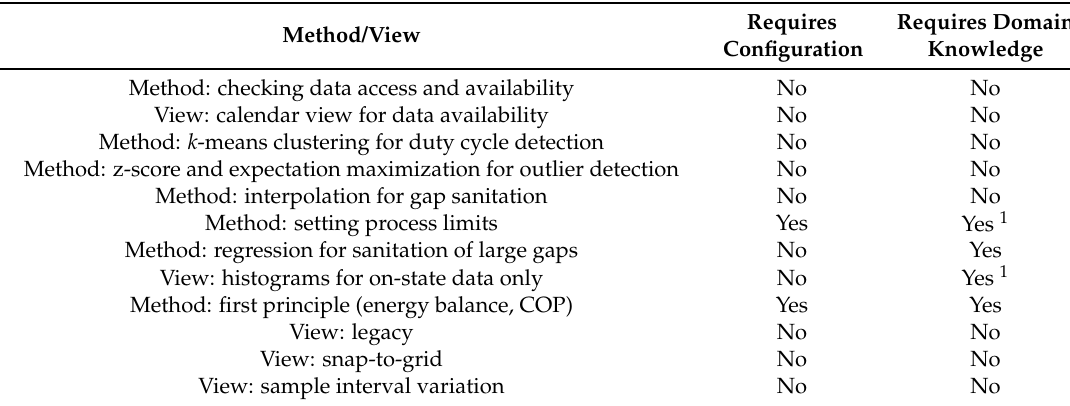
Table 1. Overview of data analysis